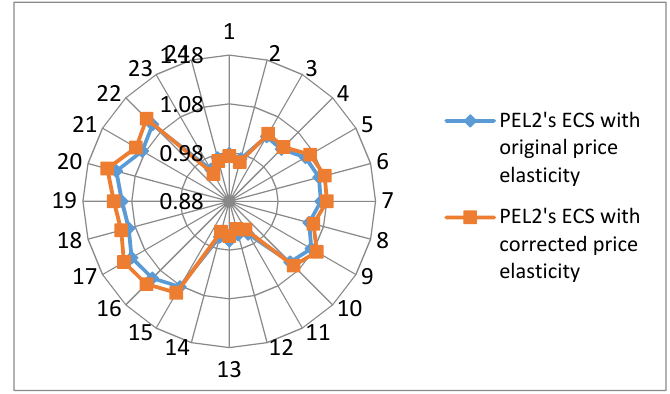
Figure 10. Interaction benefit satisfaction (IBS) of PEL 2 with changing α .